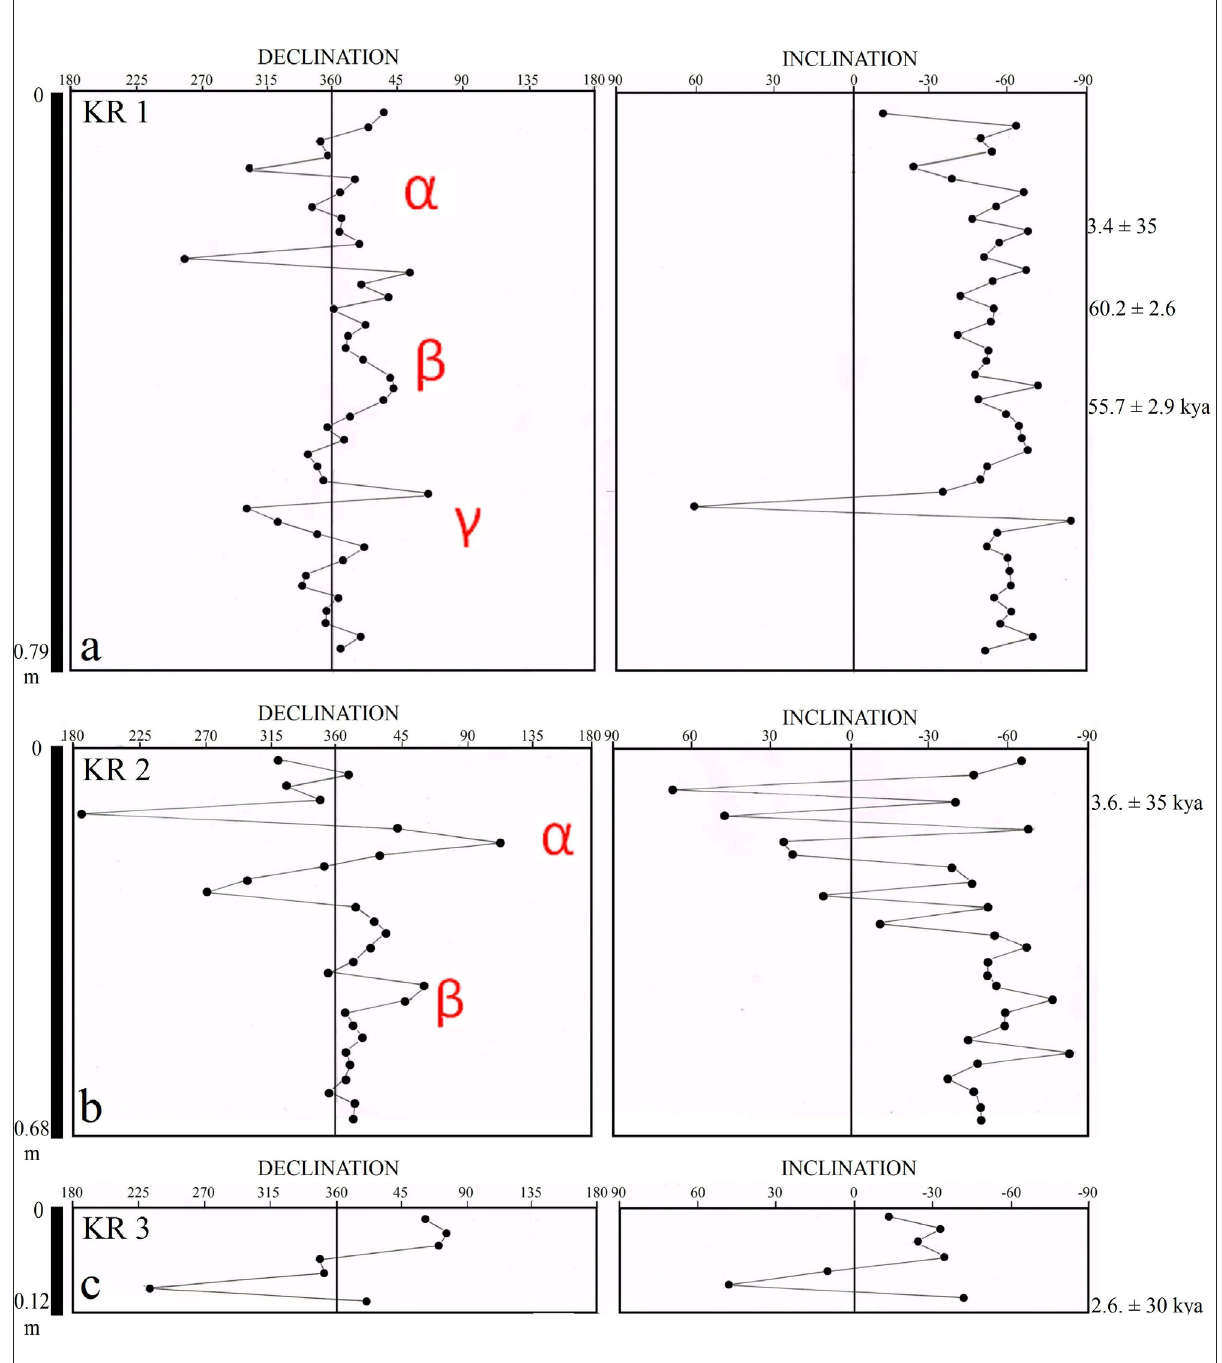
Figure 6: Declination and inclination logs according to depth and the absolute dates determined through accelerator mass spectrometry and optically stimulated luminescence from (a) KR1, (b) KR2 and (c) KR3. Greek letters denote the features with more conspicuous long direction departures from its upper ( α ) and lower ( γ ) portions, and the normal directions recorded in the middle part ( β